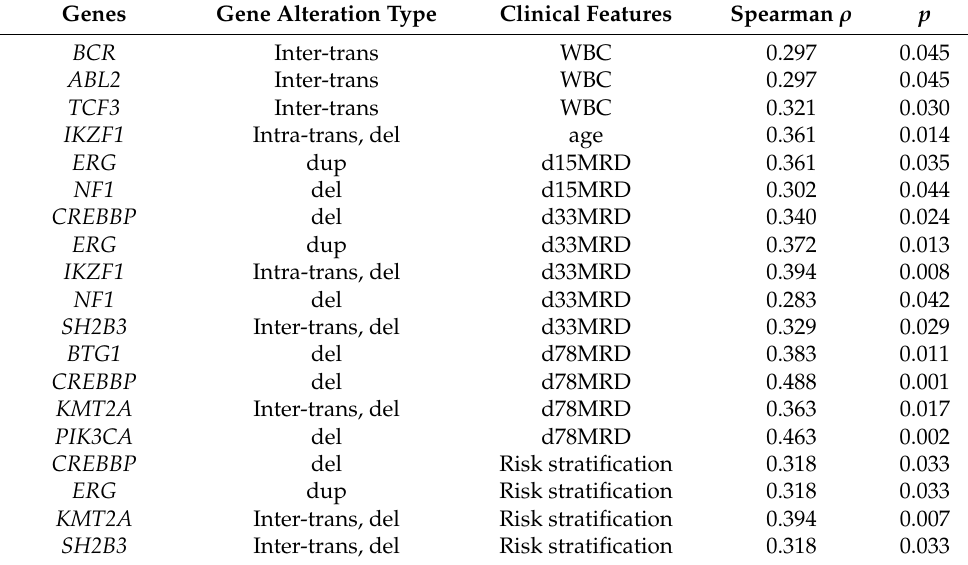
Table 7. Correlation of recurrent single-gene aberrations annotated to cosmic database with clinical features of B-ALL in children.